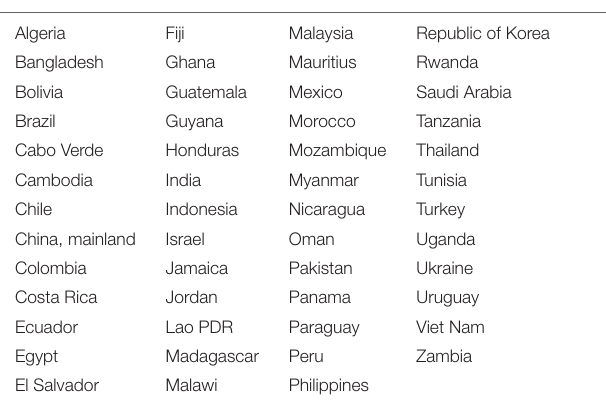
TABLE A1 | List of developing countries in the